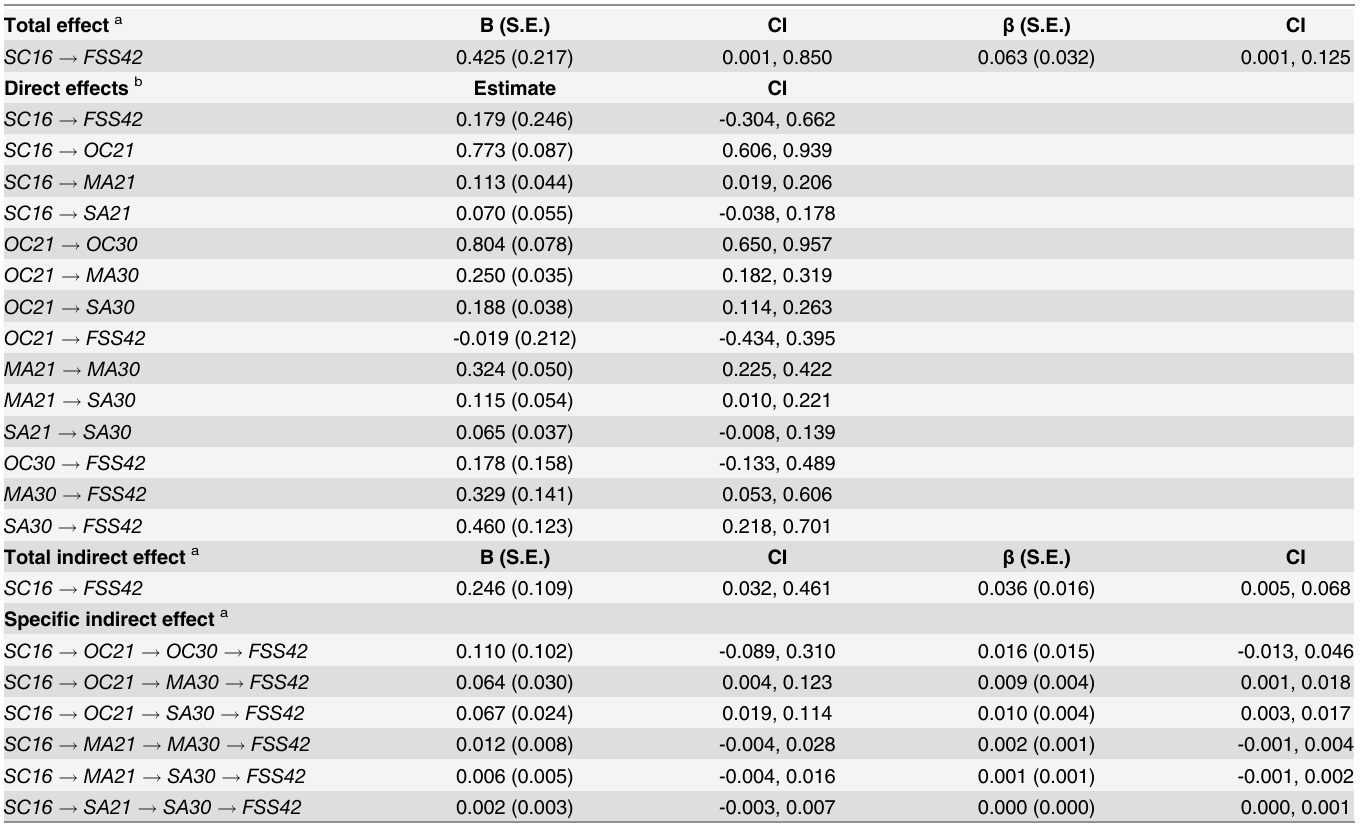
a Predictor estimates for the total, indirect, and speci fi c indirect effects are unstandardized path coef fi cients (B) with bootstrapped standard errors (S.E.) and bootstrapped 95% con fi dence intervals (CI) and standardized path coef fi cients ( β ) with bootstrapped standard errors (S.E.) and bootstrapped 95% con fi dence intervals (CI).